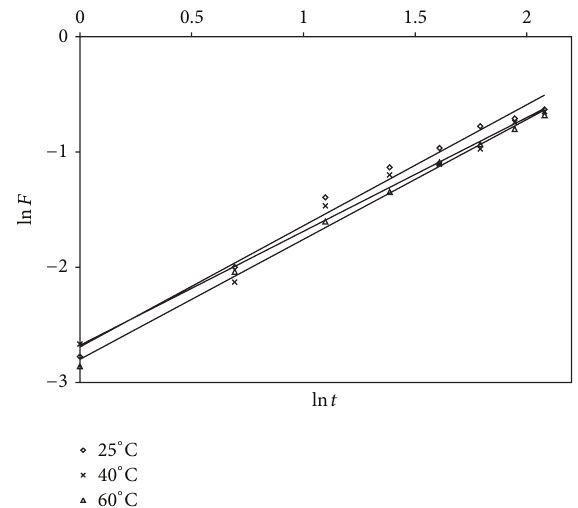
Figure3:Swellingratecurvesforhydrogelatdifferenttemperatures.